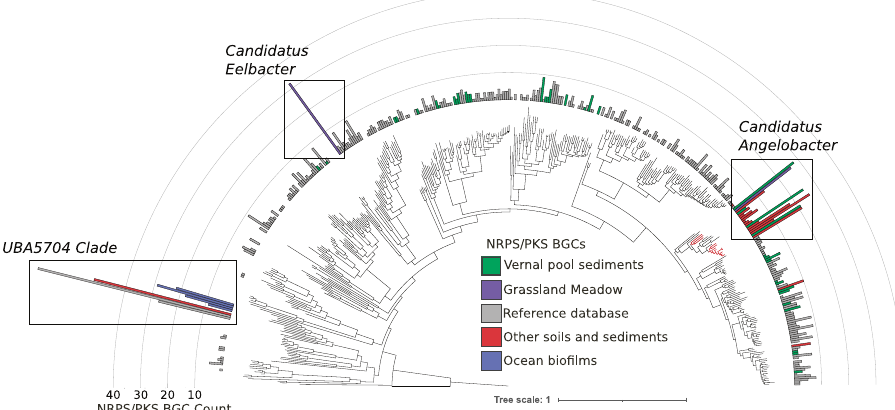
Fig. 2 Phylogeny of the Acidobacteria annotated with number of NRPS and PKS BGCs per genome. Concatenated ribosomal protein phylogeny of all Acidobacteria genomes in NCBI GenBank, additional genomes obtained from IMG, and genomes obtained from this study ( “ Vernal pool sediments ” ). Plotted is the number of BGCs annotated as NRPS and PKS per genome, and genomes are colored by their ecosystem of origin.